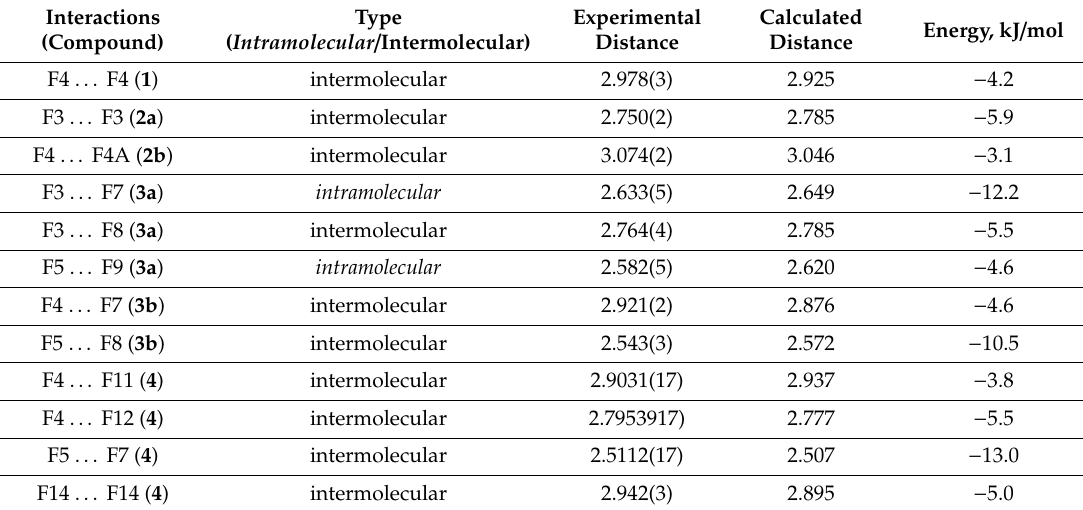
Table 2. Strongest F ... F interactions in 1–4 estimated using the EML [32] correlation.